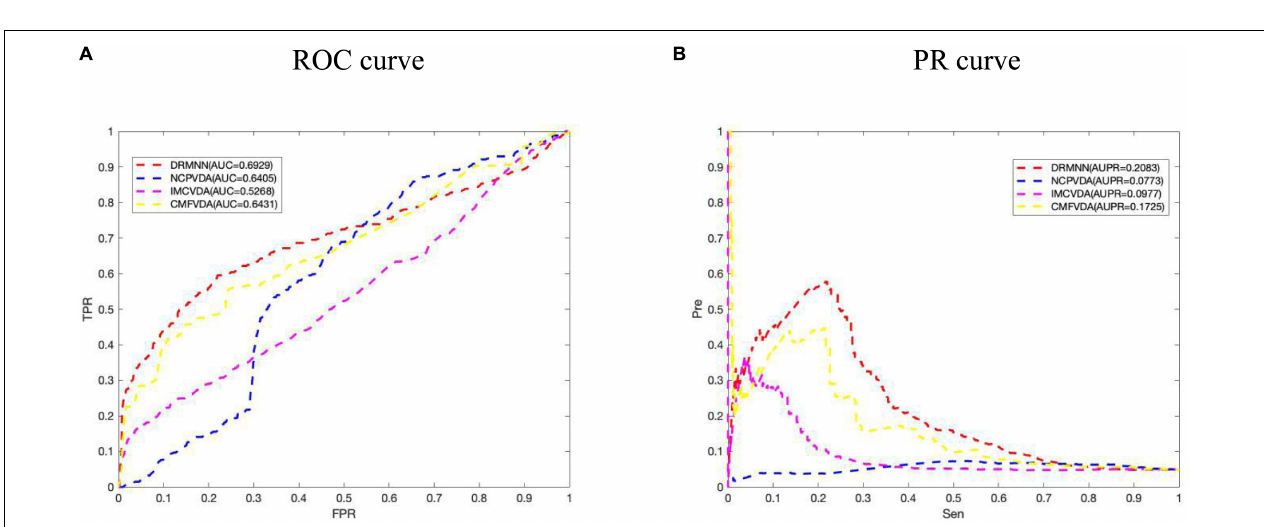
FIGURE 3 | Comparison of predictive performance of DRMNN, NCP, CMF, and IMC. (A) ROC curve and AUC value based on the local LOOCV. (B) PR curve and AUPRs value based on the local LOOCV.